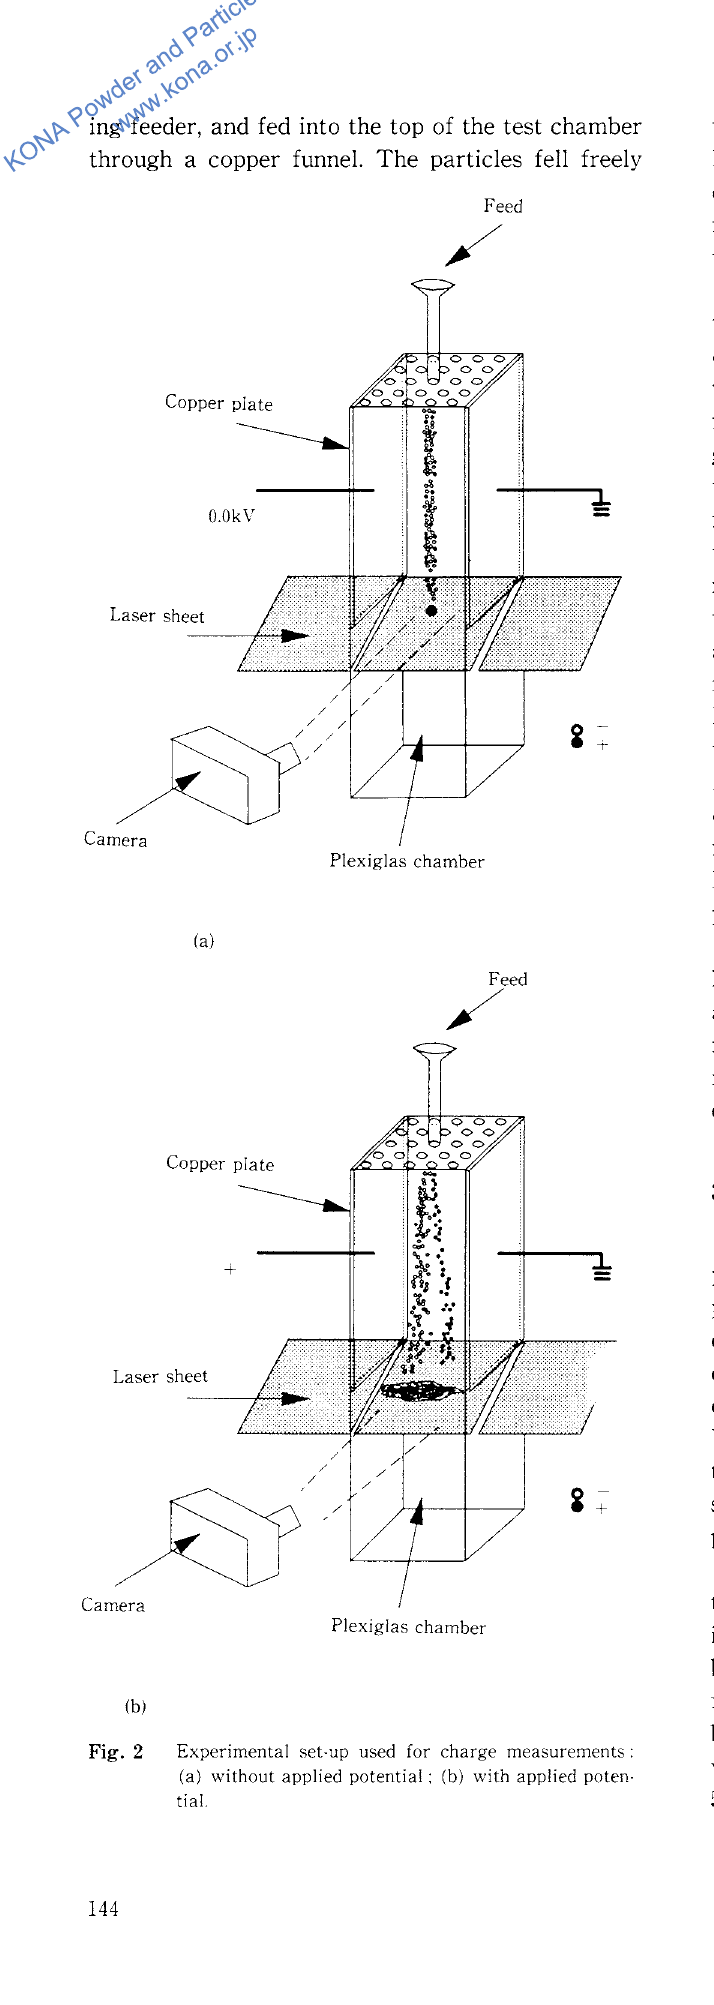
Experimental set-up used for charge measurements: (a) without applied potential; (b) with applied poten